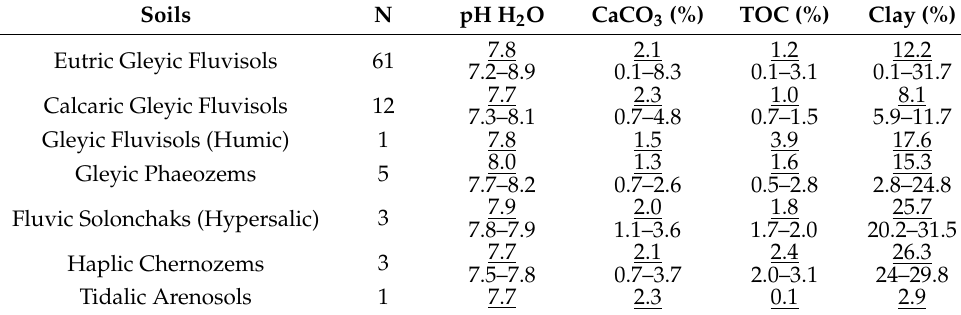
Table 1. Physical–chemical properties of soils from the study area. Soils N pH H 2 O CaCO 3 (%) TOC (%) Clay (%) Eutric Gleyic